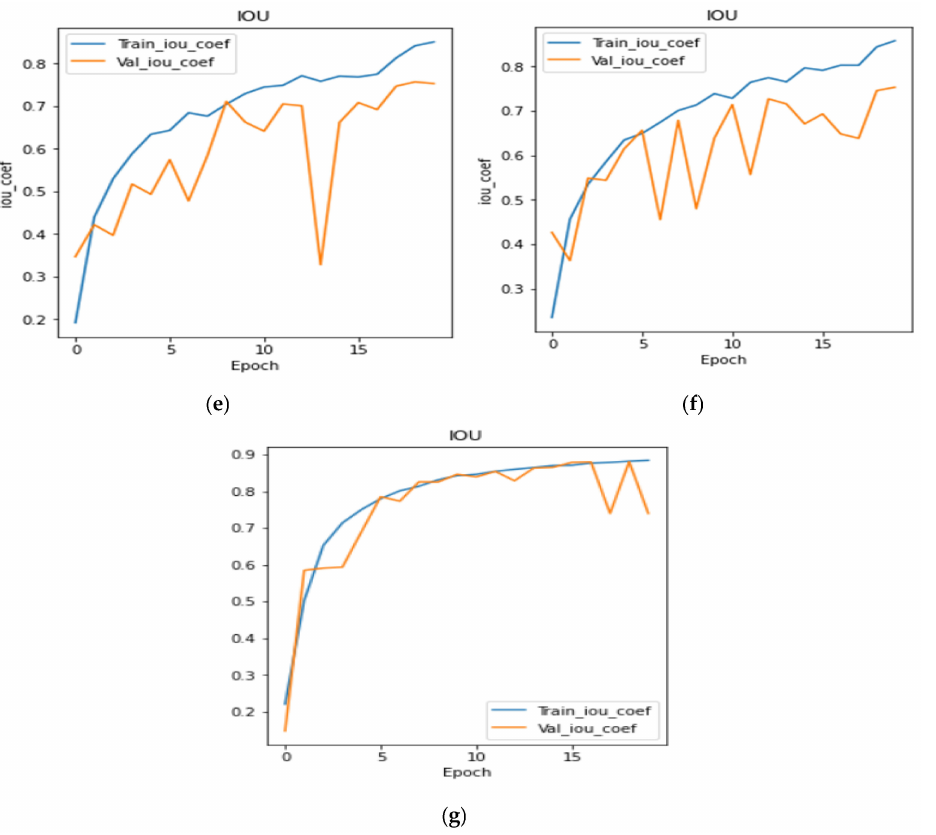
Figure 12. IoU Coefficient Plots: ( a ) DenseNet121, ( b ) Inception V3, ( c ) SeResNet50, ( d ) VGG19, ( e ) InceptionResNetV2, ( f ) EfficientNet B2, & ( g ) Proposed U-Net. Figure 13 shows the comparison of the IoU coefficient in a graphical form. It can be seen from Figure 13 that all six transfer learning models achieved similar results. The transfer learning models achieved the IoU values as 0.7687 for inception v3, 0.7588 for SeResNet 50, 0.6646 for VGG 19, 0.7486 for DenseNet121, 0.7532 for Inception ResNetV2, and 0.753 for Efficient Net B0. The proposed model achieved a 0.8819 model loss value. It can be concluded from the figure that the proposed model outperforms all the transfer learning models as it achieved the highest IoU